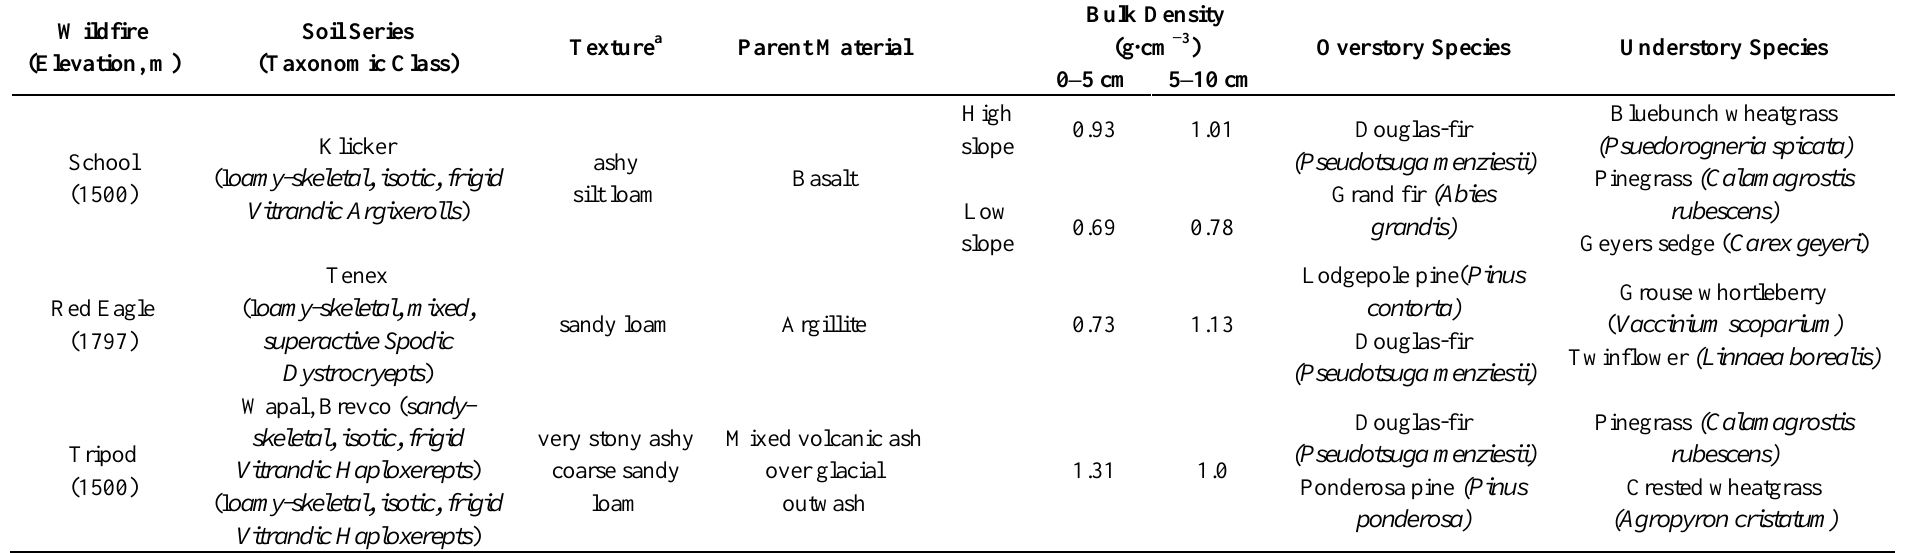
Table 1. Soil and physical characteristics of the study areas. The soil series, taxonomic class , parent material , bulk density and dominant overstory and understory vegetation are provided.